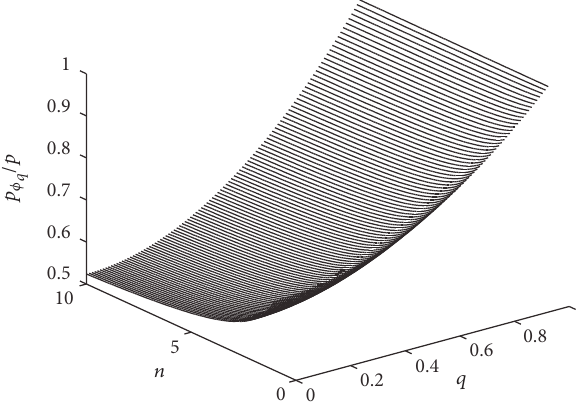
Figure 6: q -deformed energy density for various values of 𝑛 and 𝑞 , in terms of standard energy density.